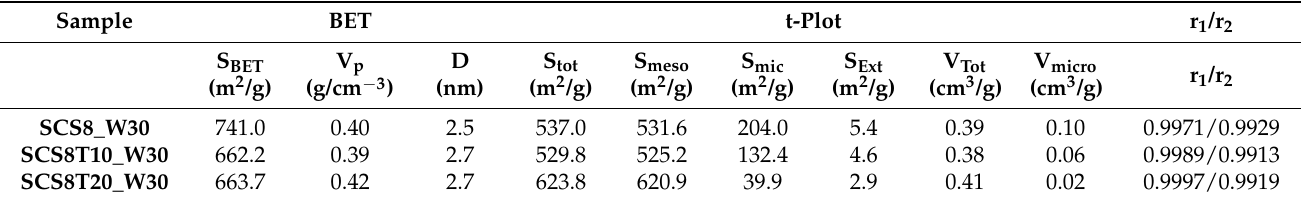
Table 3. t-plot parameters of SCS8, SCS8T10, and SCS8T20_W30